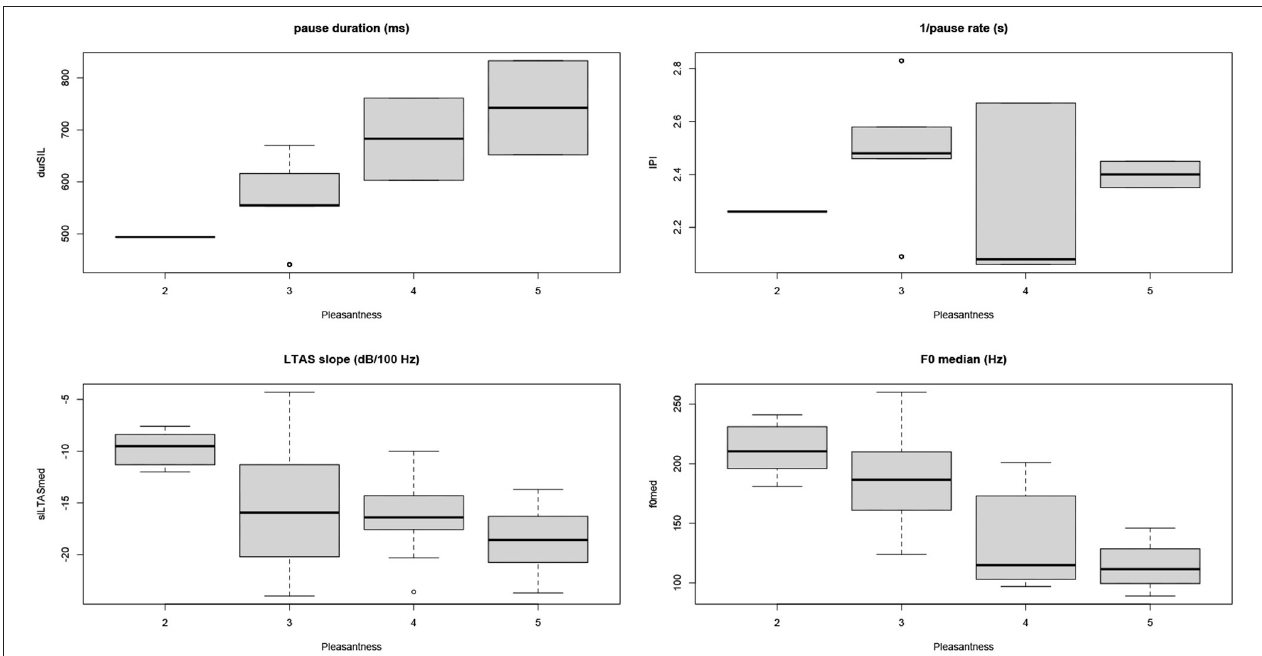
FIGURE 2 | Boxplots of the four acoustic parameters that predict pleasantness for the BP dataset.